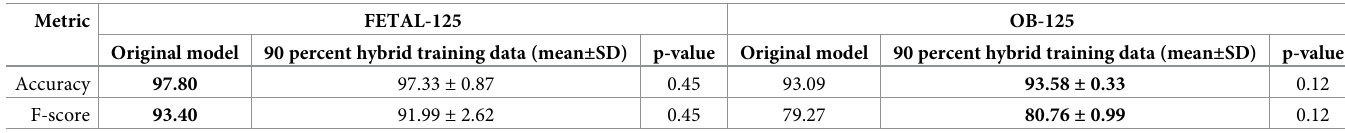
Table 2. Performance of model trained on 90 percent hybrid data generated